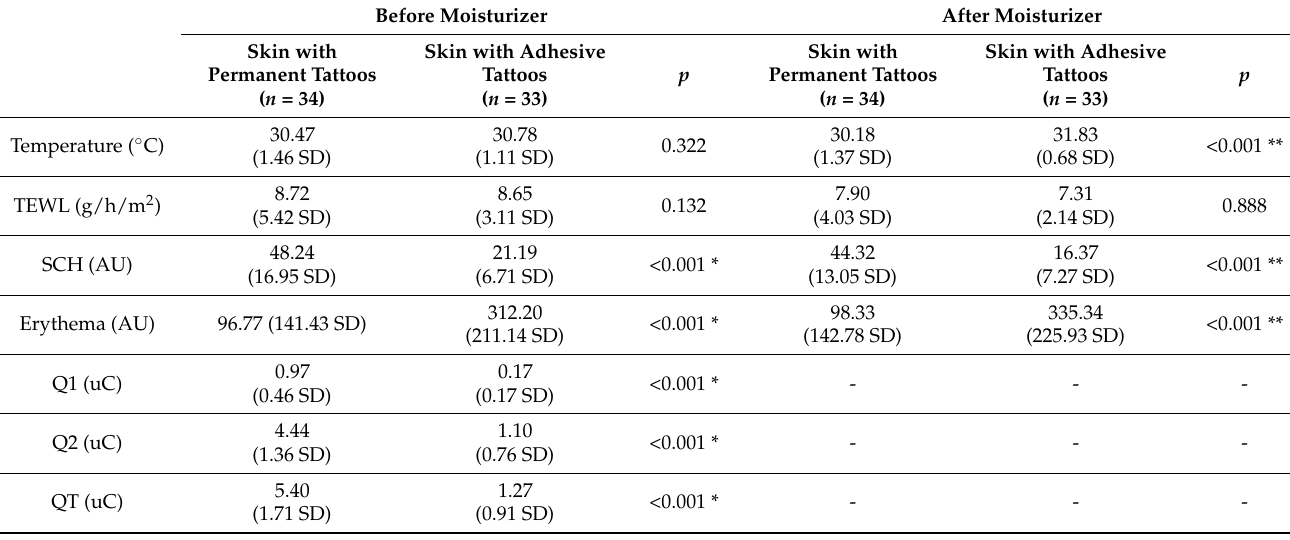
Table 4. Differences in biophysical parameters between skin with permanent tattoos and skin with adhesive tattoos. Before Moisturizer After Moisturizer Skin with Permanent